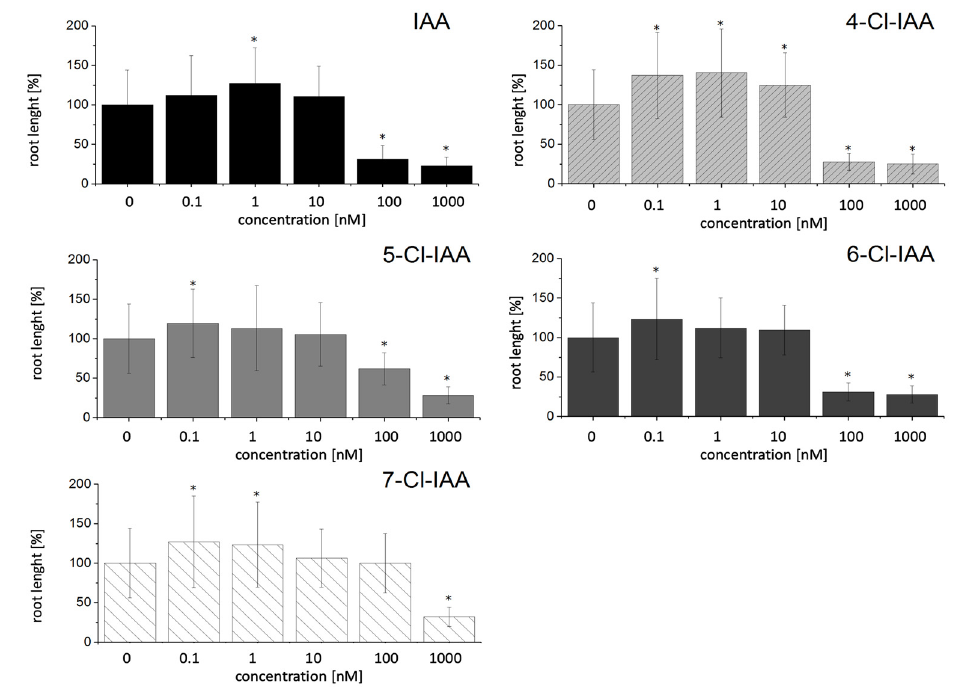
Figure 2. Effect of indole-3-acetic acid (IAA) and Cl-IAA on root length of A. thaliana wild type plants. Concentrations are given in nM. Shown are the relative root lengths 17 days after incubation on different IAA- and Cl-IAA-containing media. The results are calculated based on the control plants without any treatment to make them more comparable between different experiments. Significant differences of p<0.05 in comparison to the control plants are labeled with *. Data are mean values of N > 50 ± SD. Table 1. Production of di ff erent chlorinated indole compounds after feeding chlorinated Trp to wild type A. thaliana plants. Plants were grown for 21 days in liquid medium and 100 µ M of Trp derivatives was added. IAN = indole-3-acetonitrile, IAA = indole-3-acetic acid, IAA-Asp = IAA conjugate with aspartate, Trp = tryptophan. Concentration ranges are given as µ g g dry weight -1 . For Cl-IAA-Asp the peak could be detected but was below the quantification level ( + present; ++ higher levels present). 4-Cl-IAA could not be detected in the sample ( −